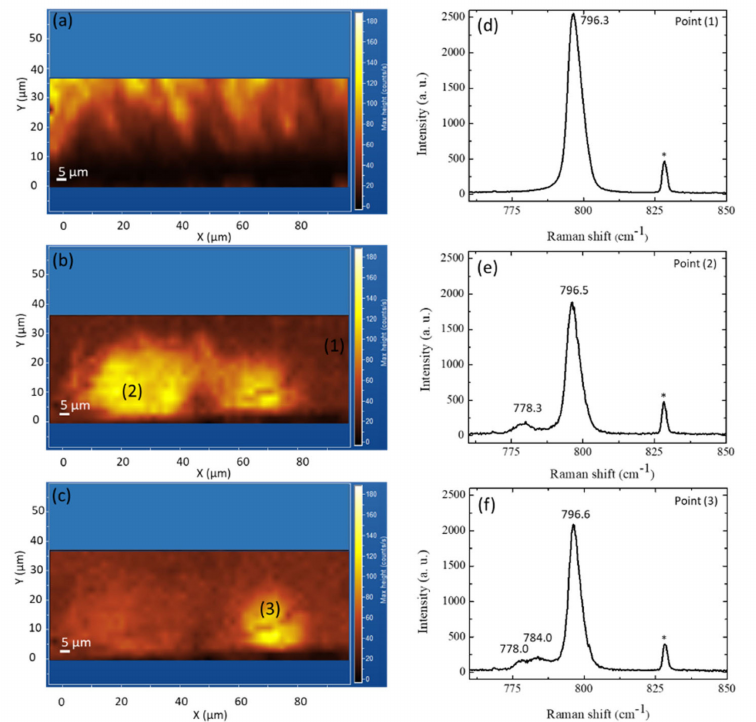
Figure 14. Micro-PL mapping ( a ) at 540 nm and micro-Raman mapping of a 3C-SiC cross-section located at ( b ) 778 cm − 1 and ( c ) 784 cm − 1 .The interface with the removed Si substrate is shown by point 0 on the Y-axis. Average Raman spectra achieved in the ( d ) area (1) of the map ( b ), ( e ) zone (2) of the map ( b ), and ( f ) zone (3) of the map ( b , c ). The laser probe created the peak located at 828.37 cm − 1 (*) (see Reference